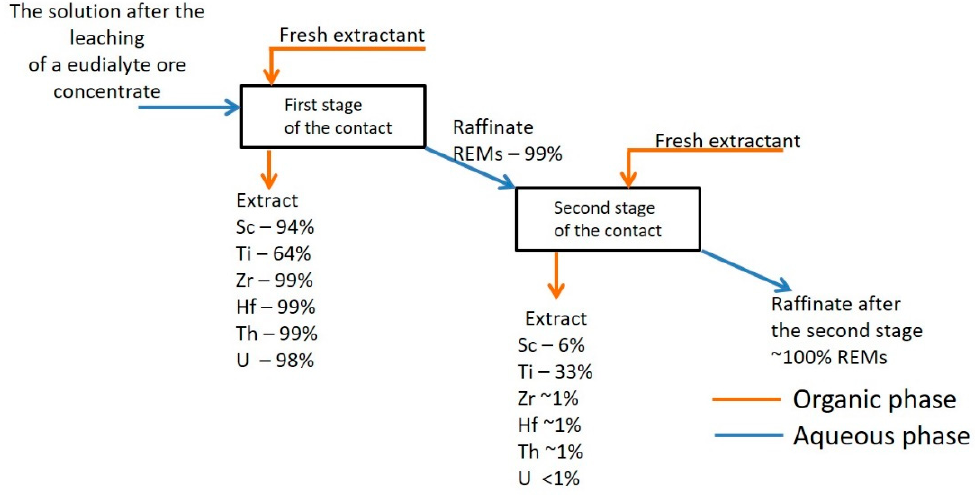
Figure 8. Scheme of two-stage exhaustive extraction.